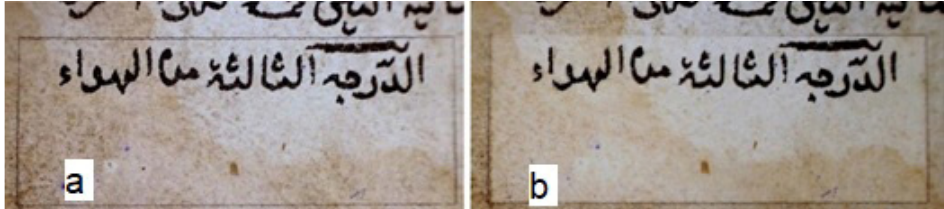
Figure 10. A fragment of antique Arabic manuscript: ( a )—before cleaning, ( b )—after laser treatment.